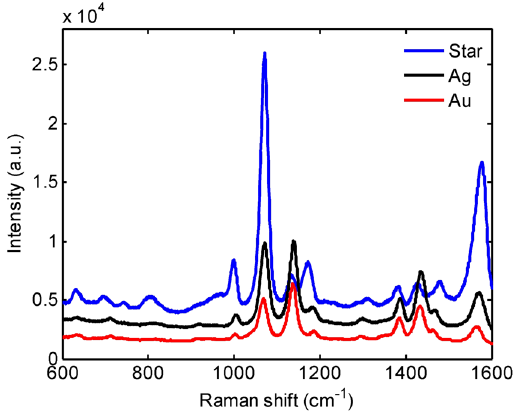
Figure 3. Raman spectra of 4-ATP molecule with the silver film-based substrates. Raman spectra of 4-ATP molecule with the silver film-based substrates employing gold, silver, and star-shaped gold/silver